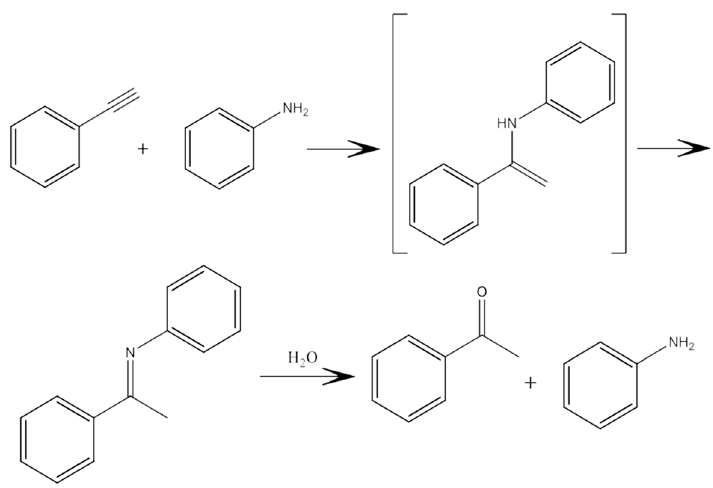
Scheme 1. Hydroamination of phenylacetylene with aniline over Au-NP.